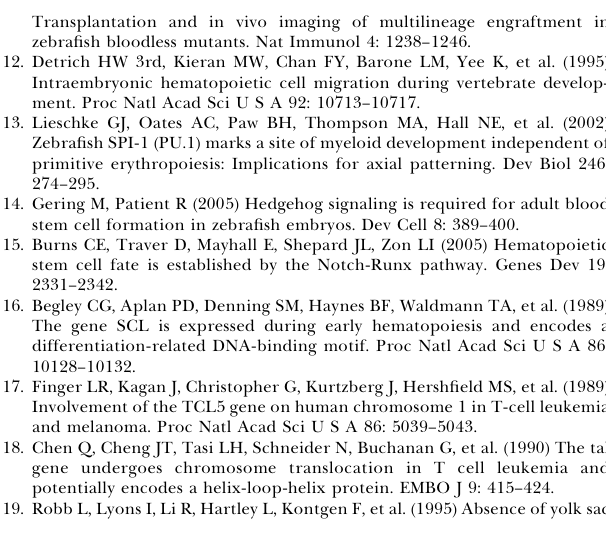
Figure S1. Sequence Alignment of Zebrafish Scl- a / b and Human and Mouse Full-Length SCL Proteins The full-length scl- a encodes a protein of 324 aa, whereas scl- b encodes a truncated protein lacking the N-terminal 118 aa. The predicted translation start site (indicated by arrow) of scl- b is conserved between zebrafish, human, and mouse. The basic helix- loop-helix domain is highlighted in red. Figure S2. The Artery Endothelial Cells Are Retained in Both scl- a and - b Morphants WISH of artery-specific markers deltaC ([A], n ¼ 42/42; [B], n ¼ 41/44; and [C], n ¼ 45/46) and grl ([D], n ¼ 40/40; [E], n ¼ 45/46; and [F], n ¼ 44/ 47). At 24 hpf, expression of deltaC and grl was only slightly reduced in both scl - a ([B and E], arrowheads) and - b morphants ([C and F], arrowheads) when compared to the control embryos ([A and D], arrowheads). Found at doi:10.1371/journal.pbio.0050132.sg002 (5.0 MB